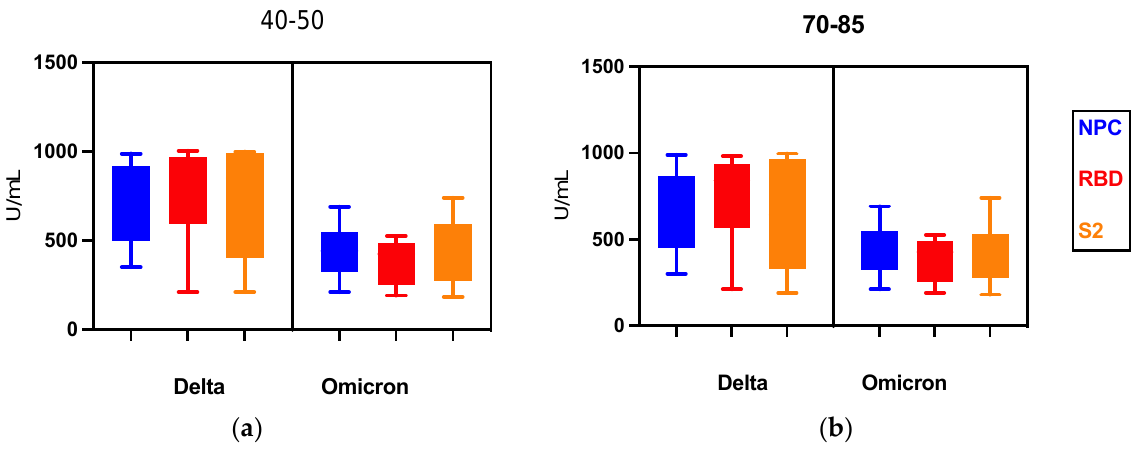
Figure 2. The serum level of NCP, RBD, and S2 antibody in patients after SARS CoV-2 Delta variant and Omicron variant infection by sex.